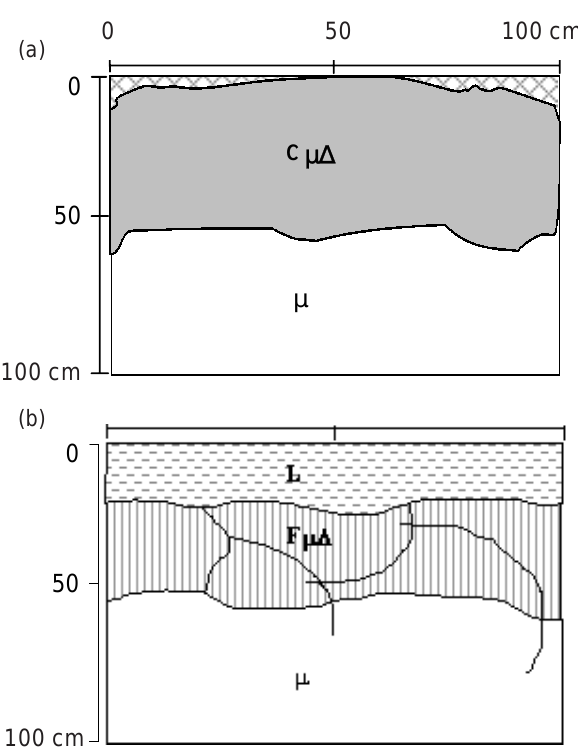
Figura 2. Perfis Culturais: (a) sob semeadura direta em LRd (Cascavel - PR), (b) sob arado de aivecas em LR (Palotina -